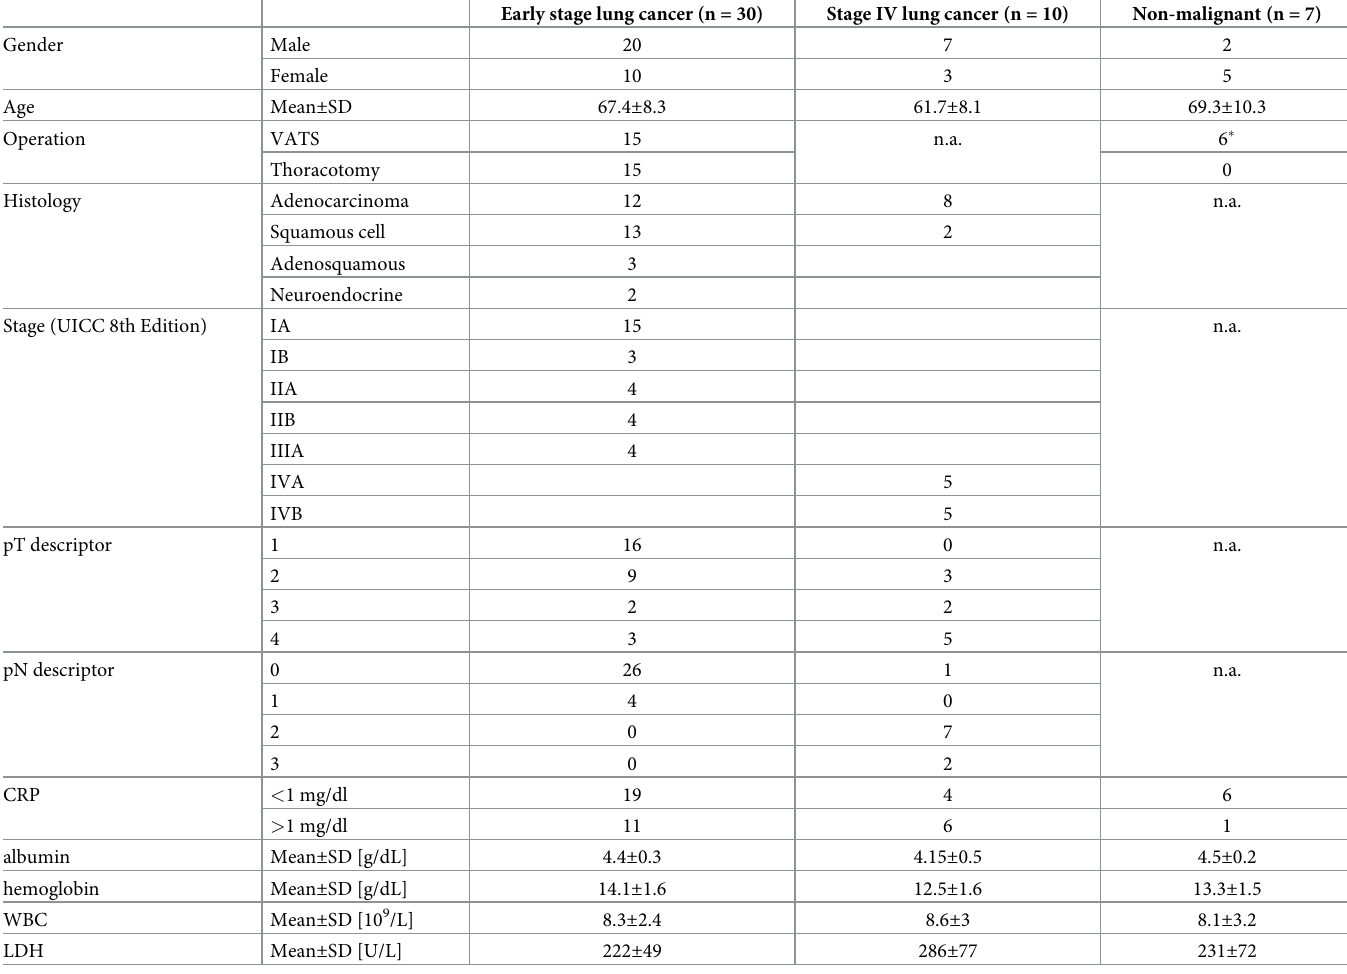
Table 1. Clinicopathological characteristics of the patient